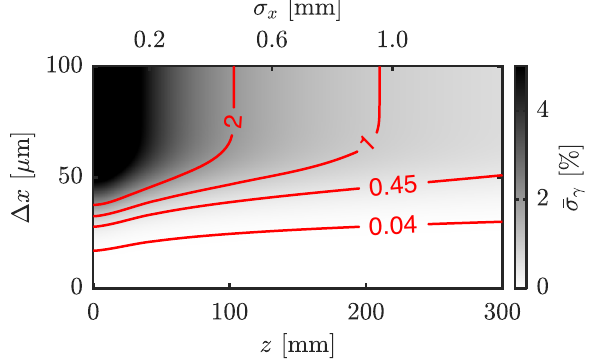
FIG. 10. Relative energy spread increase due to ICS at the output of the final stage of a staged 50 GeV LWFA (see Sec. V B) using a shaped profile reflector. The corner of the profile is Δ x from the electron beam axis at a drift distance of z . The λ ¼ 1 μ m, exit of a plasma of density 10 17 cm − 3 .